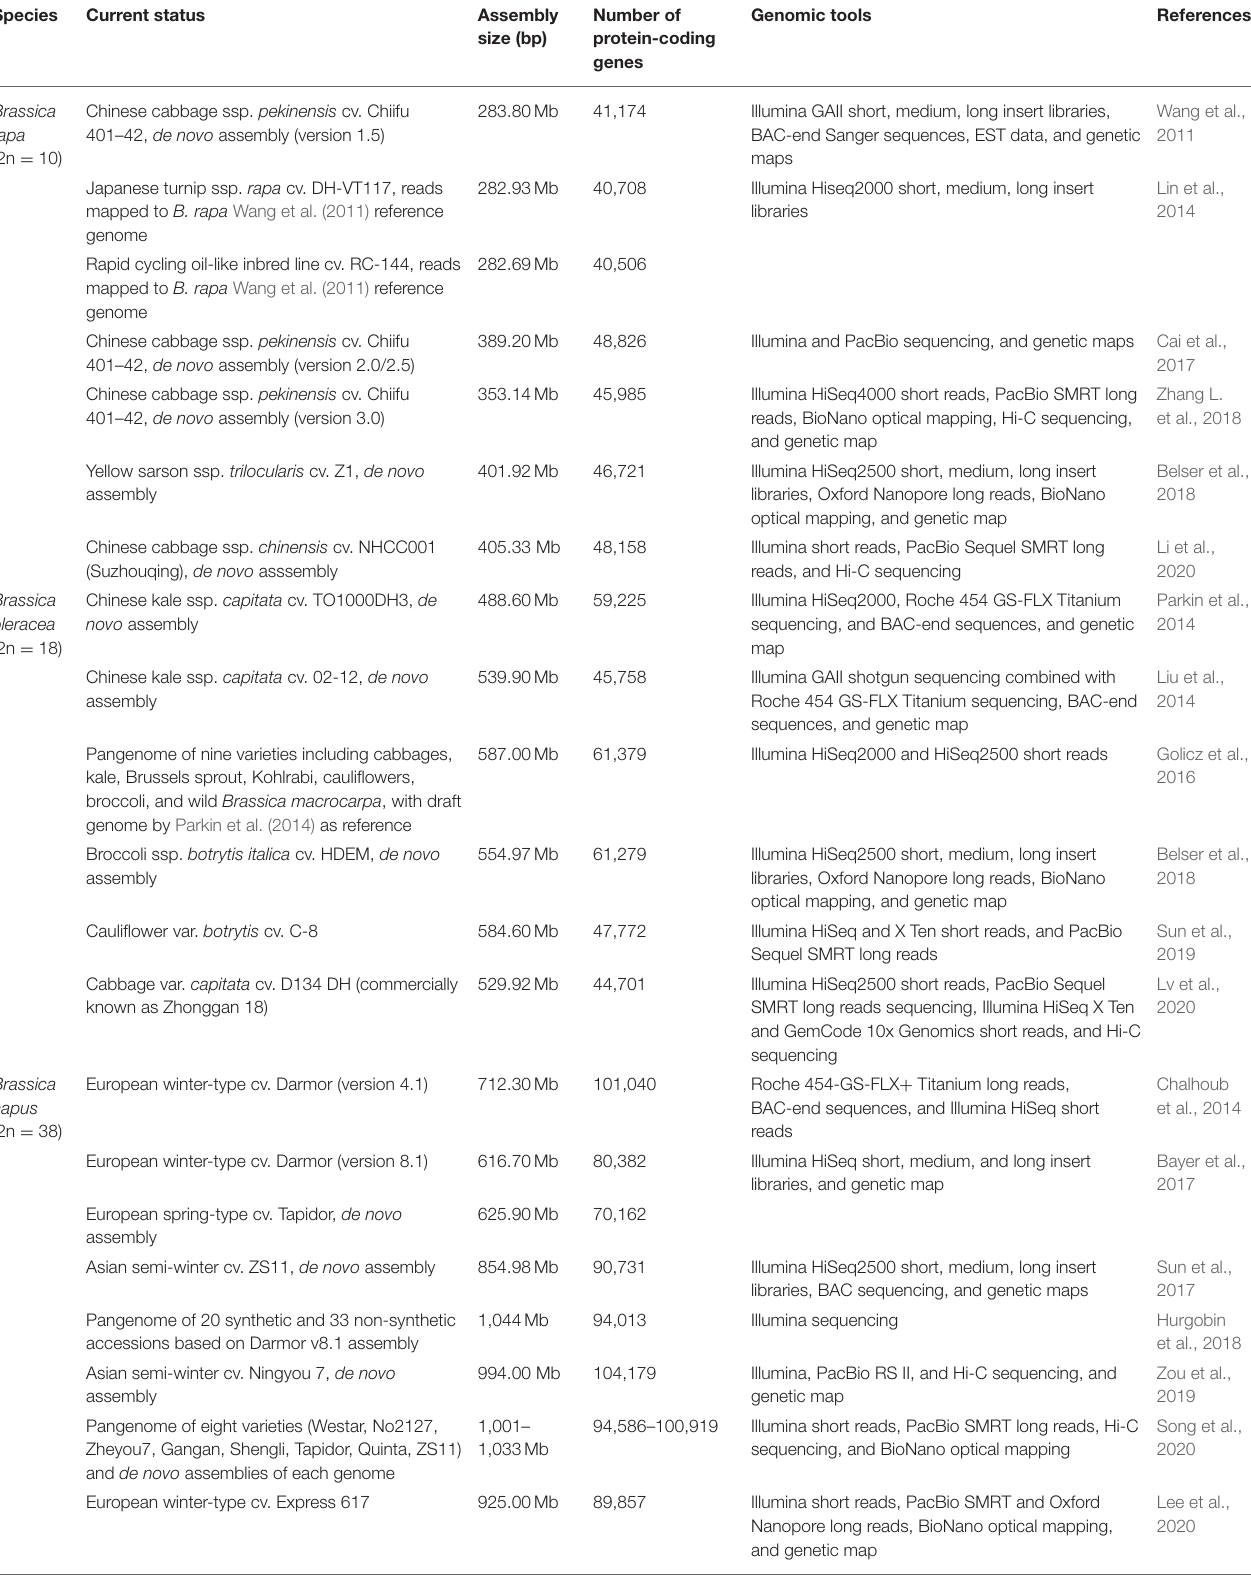
TABLE 1 | List of domesticated and wild Brassica species nuclear genome